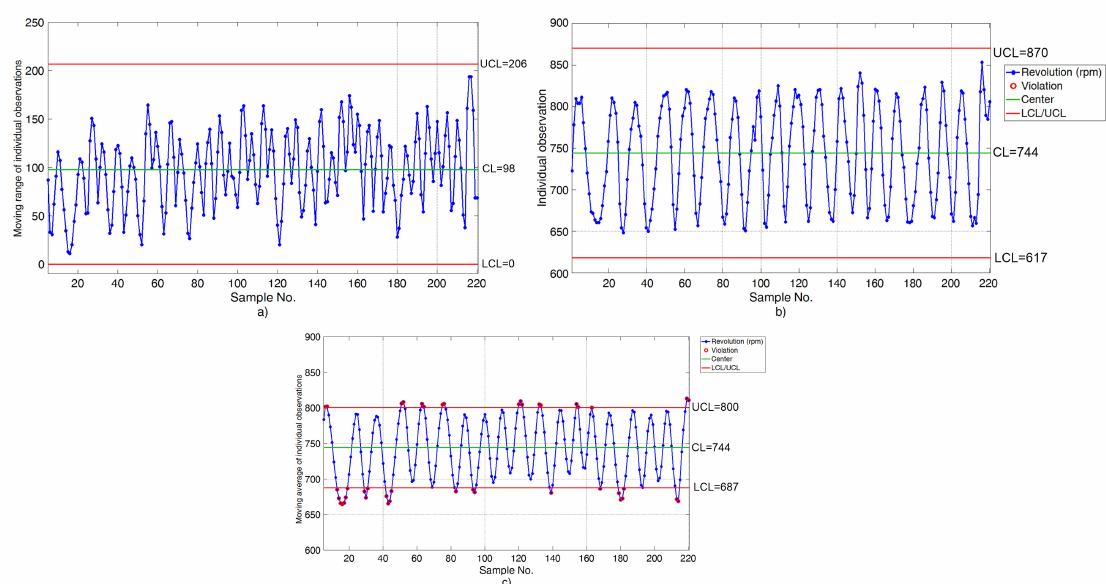
Figure 11. Control charts for the technological parameter of revolutions ( a ) diagram of moving range, ( b ) diagram of individual values, ( c ) diagram of moving